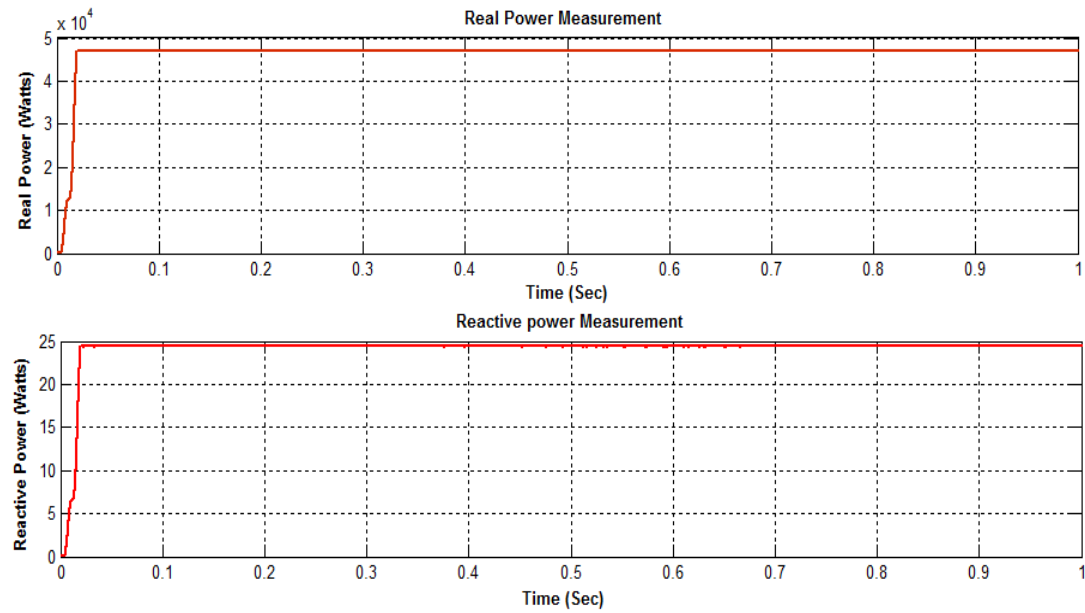
Figure 10. Measurements of the real and reactive power on the load side.